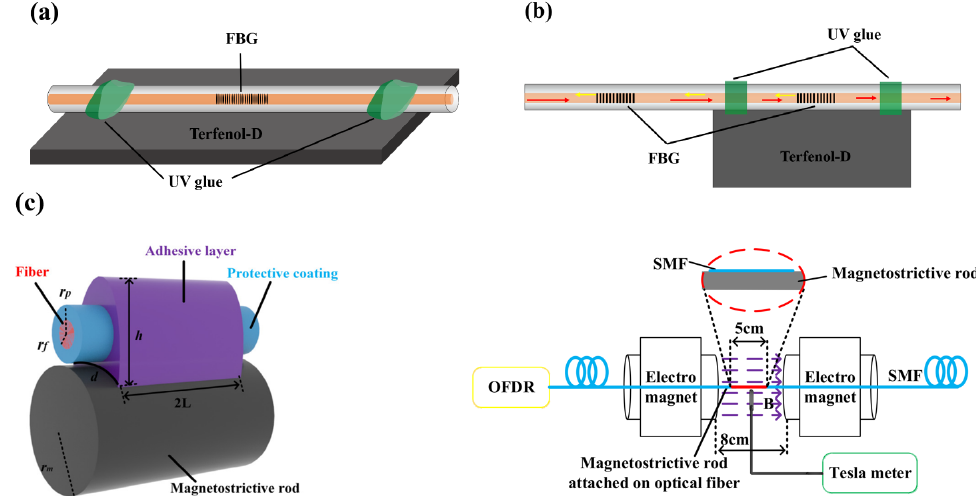
Figure 10. Magnetic field fiber sensors based on the ribbon–type transducer with ( a ) a single-point structure [78], ( b ) a cascaded structure [80], and ( c ) a quasi-distributed structure (reprinted with permission from Ref. [82], 2022, MDPI).